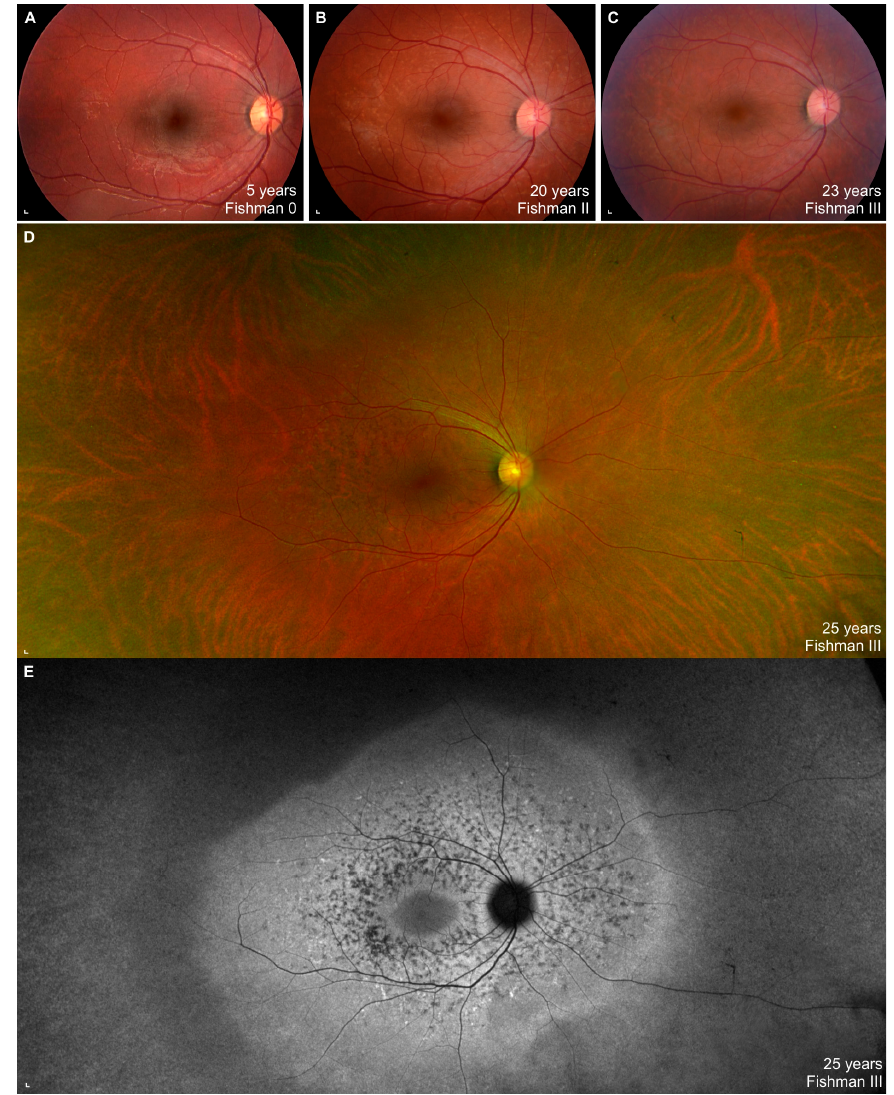
Figure 1. Right eye color fundus images and fundus autofluorescence (FAF) Optos image from a WDR19 patient from the first until the last exam. Note the progression from normal fundus ( A ; Fishman 0) to extensive flecks ( B ; Fishman II) to resorbed flecks ( C – E ; Fishman III). Scale bars: 200 µm.